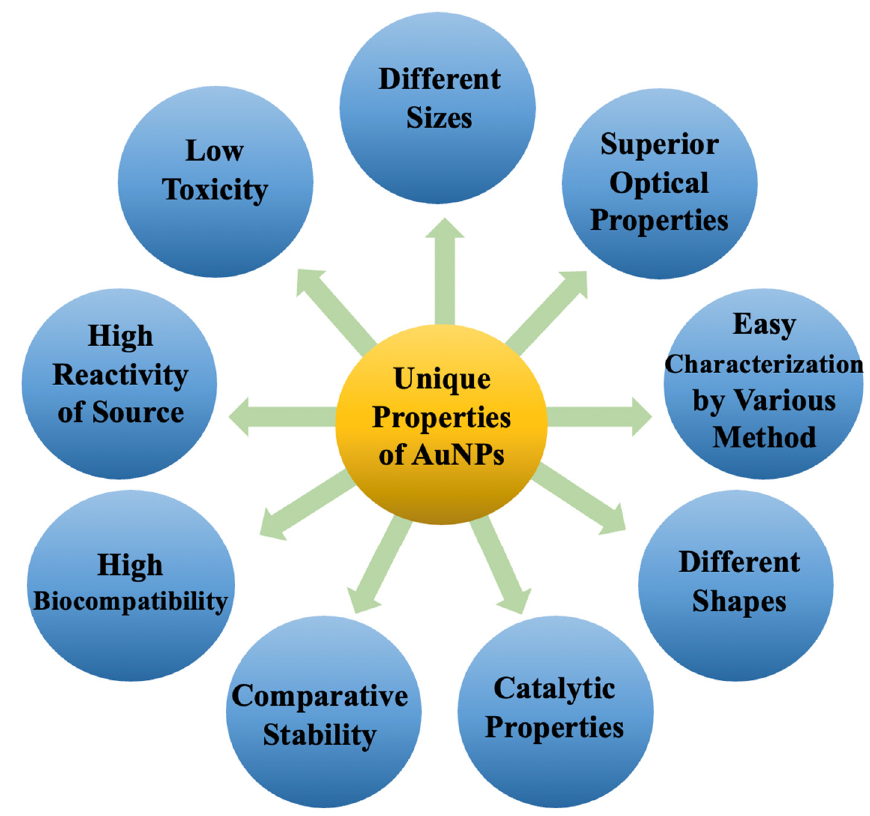
Figure 4. Unique properties of AuNPs.